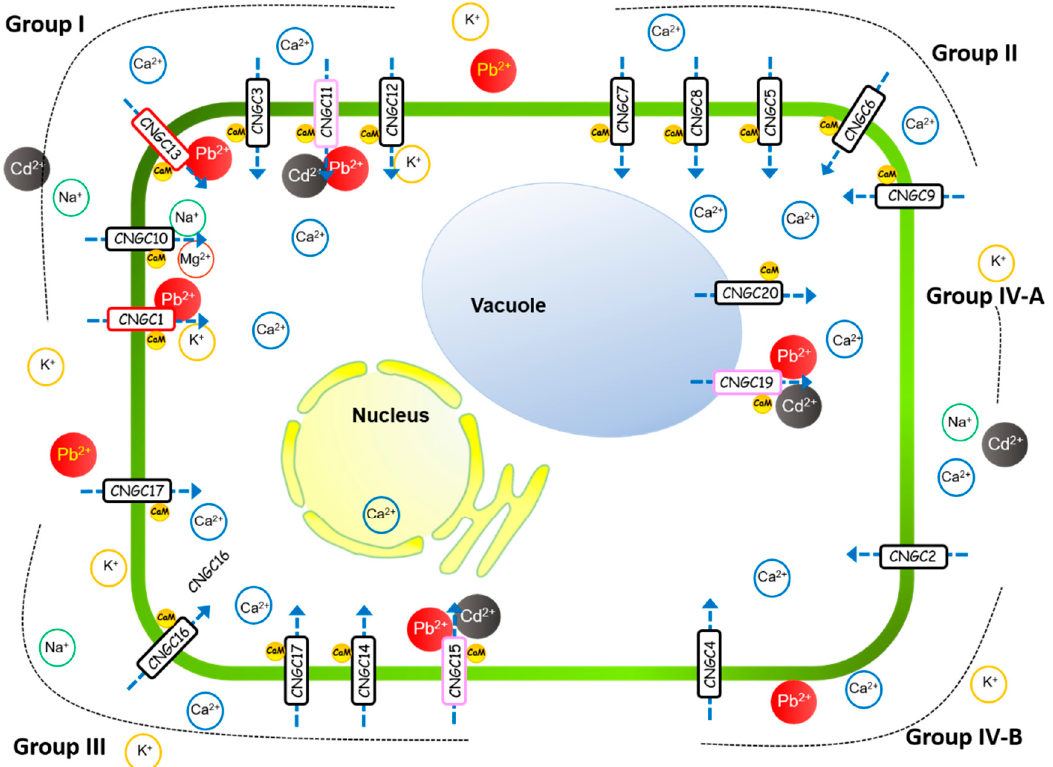
Figure 6. Model of the involvement of AtCNGC family members in ion transport in plants. AtCNGC members are divided in five groups according to the alignment of their predicted amino acid sequences, and locate to the plasma membrane (group I, II, III, IV-B) or vacuolar membranes (IV-A) (drawn as adjacent shapes with arrows) [12,29]. Ions are transported with the help of Ca 2+ -permeable AtCNGC family members dependent on the different ions. AtCNGCs in red rectangle: for Pb 2+ entry, AtCNGCs in pink rectangle: for Pb 2+ or Cd 2+ entry.